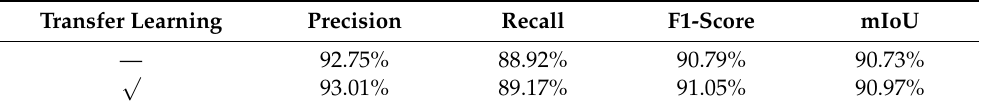
Figure 14. Building extraction results with and without transfer learning. ( a ) Original image. ( b ) Ground truth. ( c ) EfficientUNet+ with transfer learning. ( d ) EfficientUNet+ without transfer learning. Table 6. Accuracy comparison of prediction results with and without transfer learning.